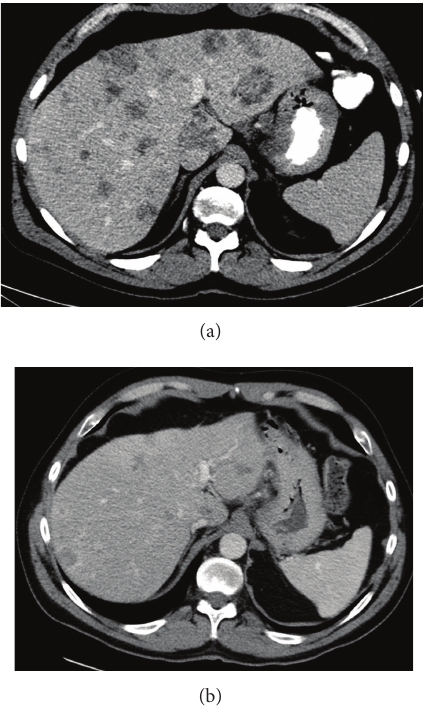
Figure 2: (a) Computed tomography imaging at presentation. (b) Computed tomography imaging after three cycles of